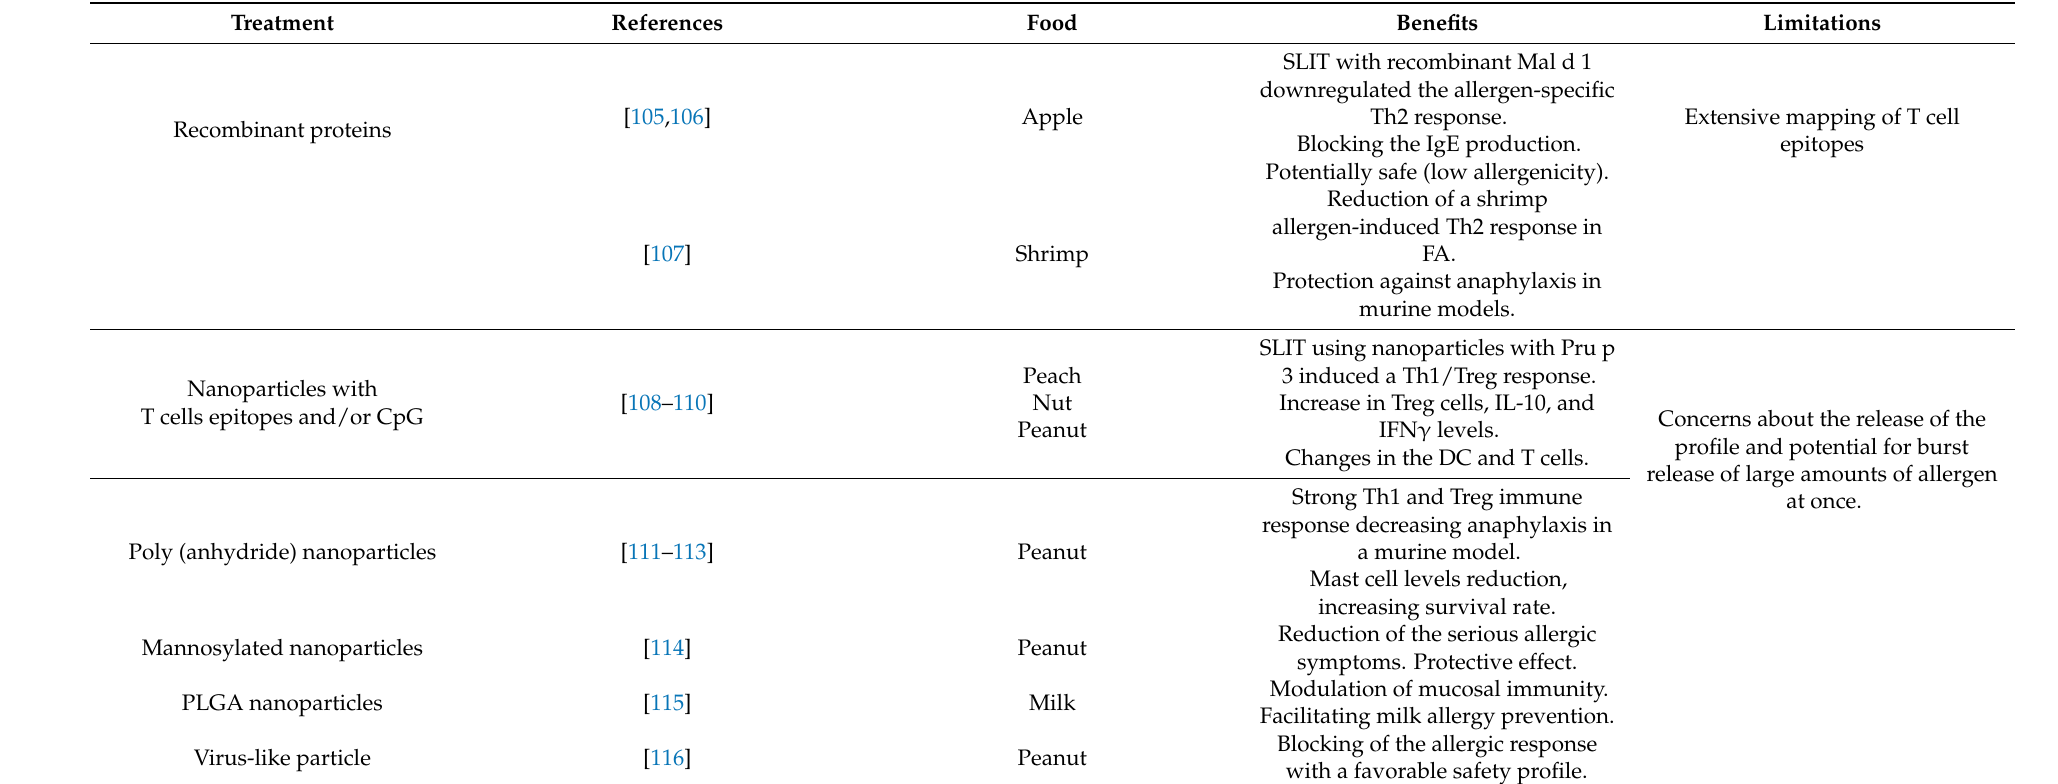
Table 2. Summary of new current therapies for